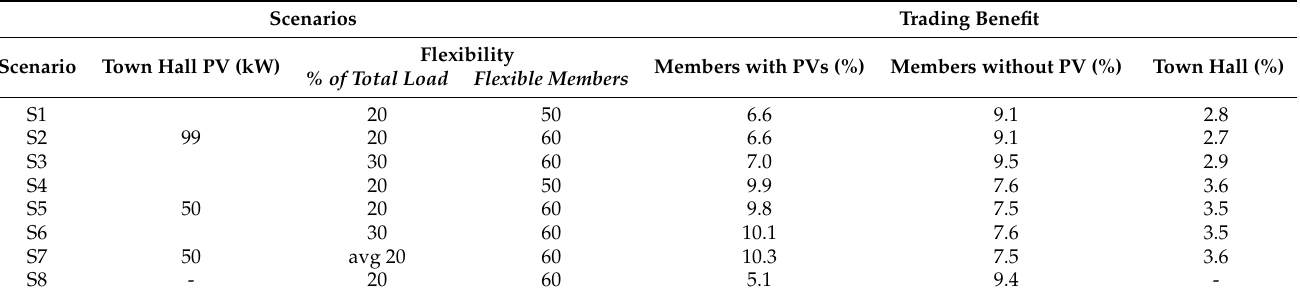
Table 3. Trading benefit for the market